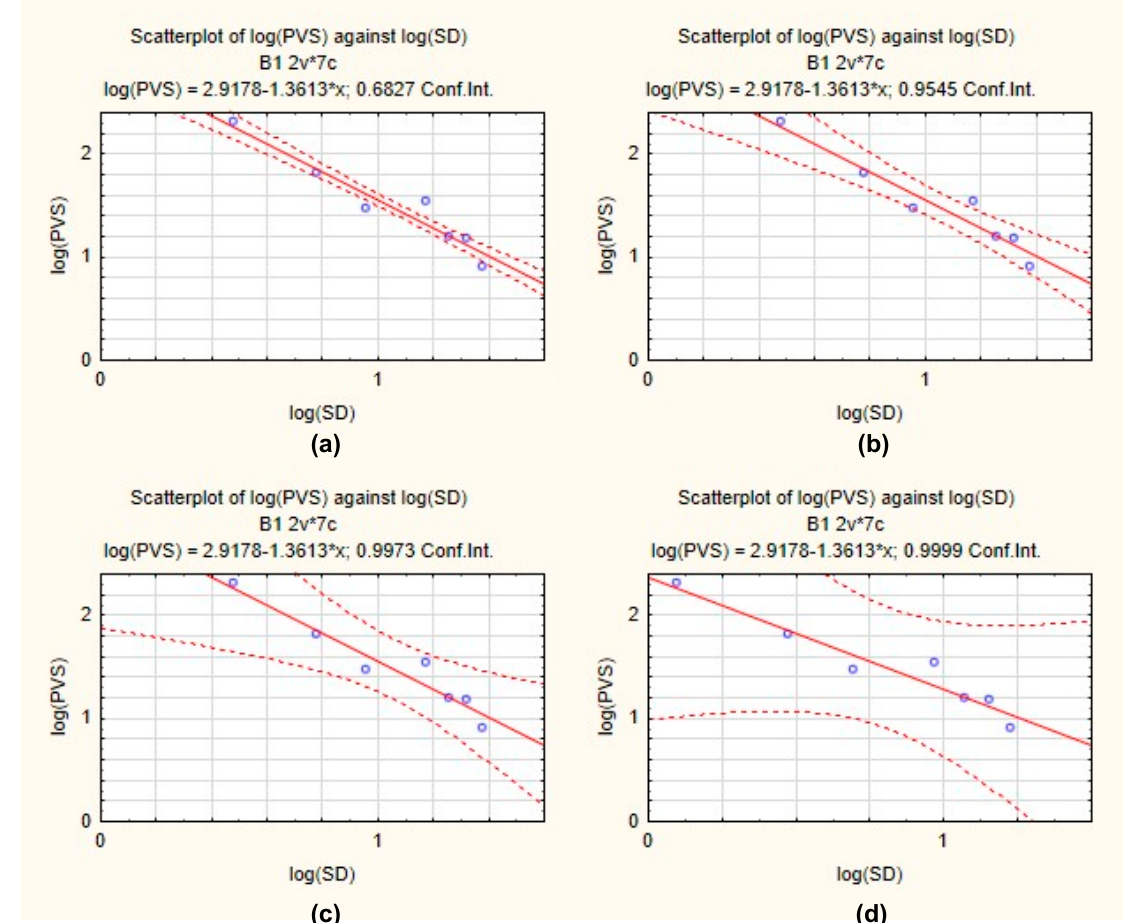
Figure 3. Detection of the atypical values (outliers) for the blast-induced seismic effects measured data for borehole B1 with confidence intervals of ( a ) 0.6827; ( b ) 0.9545; ( c ) 0.9973; and ( d ) 0.9999.